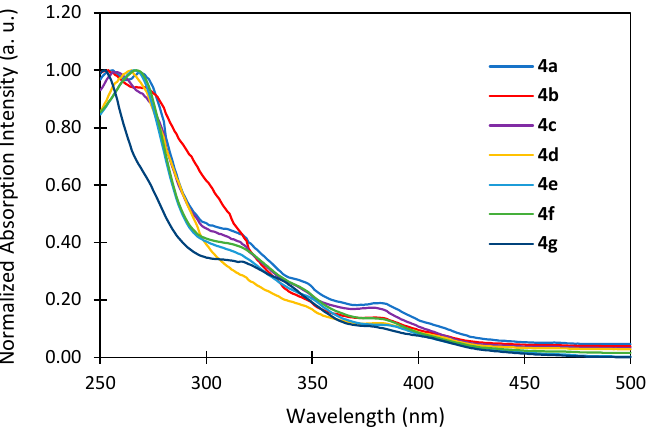
Figure 7. The strong absorption bands below 300 nm correspond to spin-allowed 1 π → π * electronic ligand-centered (LC) transitions [71]. The structureless bands at 300–360 nm are attributed to ppy-to-ppy 1 π → π * ligand-centered charge transfer (LLCT) and Ir-to-ppy metal-to-ligand charge transfer (MLCT) transitions [71,72]. The lowest-lying bands in the visible region can be assigned to both singlet and triplet MLCT transitions [71–73]. No significant difference in the absorption spectra of complexes 4a to 4g can be found in the CH 2 Cl 2 solution.